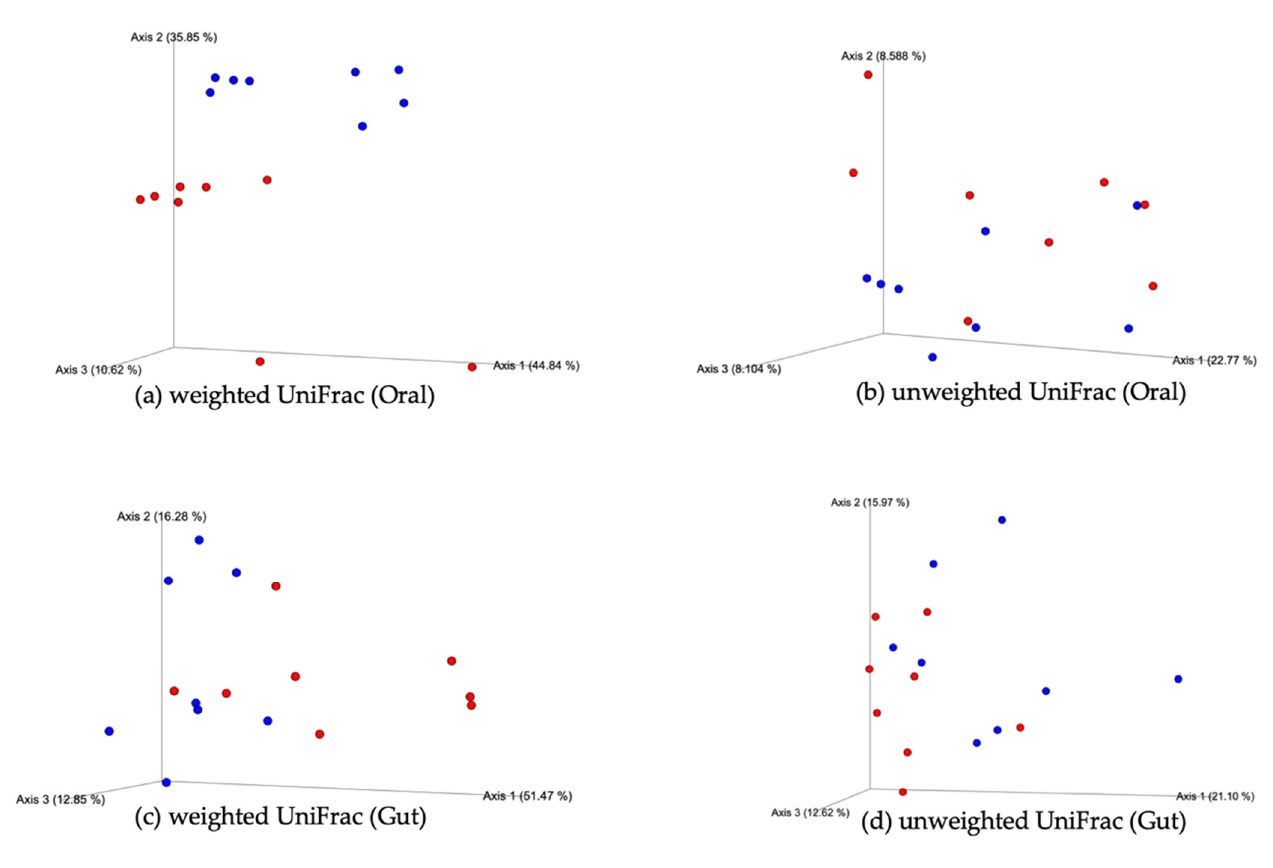
Figure 4. PCoA of the weighted and unweighted UniFrac (beta diversity) distances in the oral and gut bacteria. ( a , b ) The weighted UniFrac distances of the oral microbiome significantly differed between the control (blue dots) and BP groups (red dots) (PERMANOVA; p = 0.001; q = 0.001). ( c , d ) The weighted ( p = 0.006; q = 0.006) and unweighted UniFrac ( p = 0.032; q = 0.032) distances of the gut microbiome significantly differed between the control and BP groups.